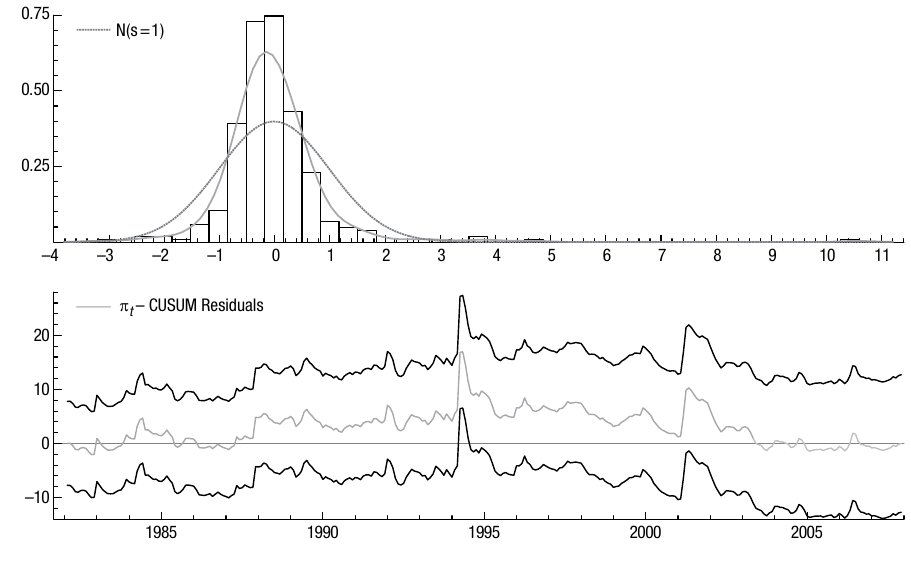
Fig. A3. Residuals of the unobserved components Table A1. The descriptive statistics for p